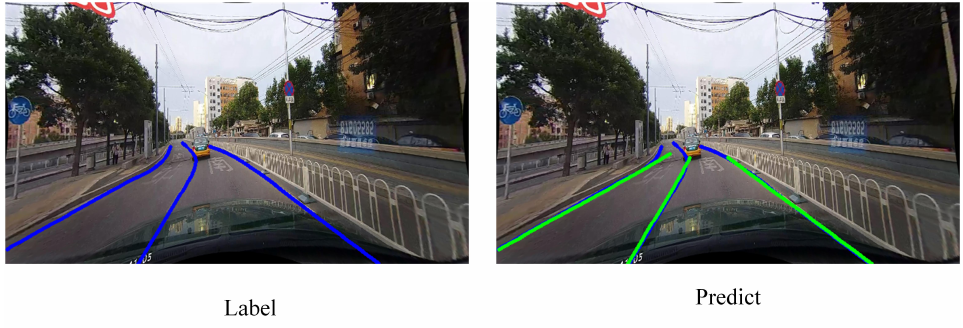
Figure 8. Curve lanes predictions on CULane.